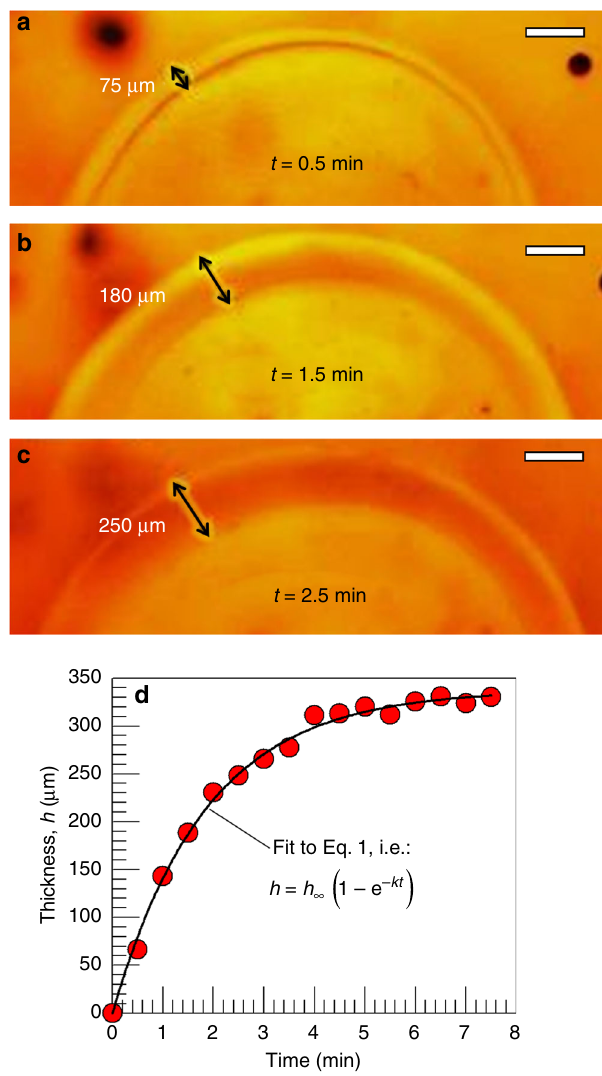
Fig. 3 Kinetics of layer growth, visualized directly by optical microscopy. At time t = 0, an alginate gel core of 2 mm diameter, loaded with 15 mg/ml ammonium persulfate (APS) initiator, is placed in a solution of 1 M DMAA monomer (together with cross-linker and accelerant). Still images at various time points are shown in a , b , and c , and these reveal the growth of the polymer layer around the core. Scale bars in the images are 200 µ m. In d , a plot of the layer thickness h vs. t is shown, and the solid curve through the data is a fi t to Eq.